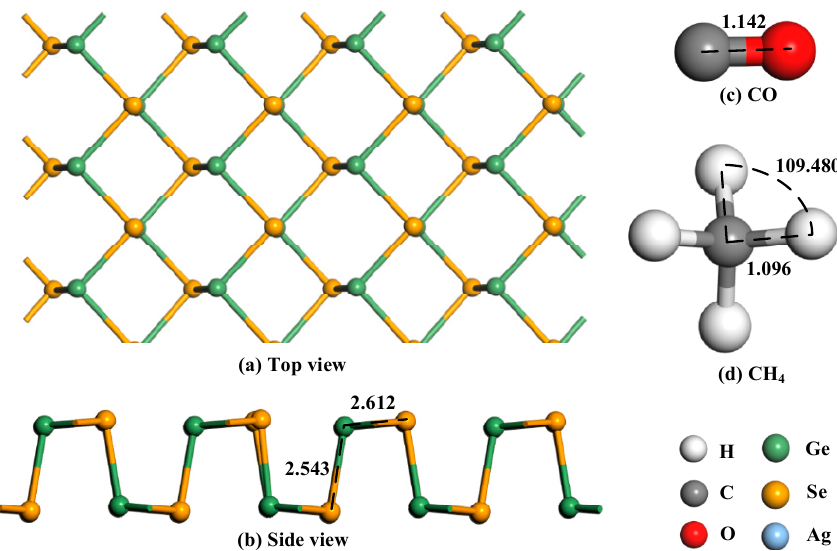
Figure 1. Structures of GeSe and gas molecules ( a ) Top view, ( b ) side view, ( c ) CO molecule, ( d ) CH 4 molecule. The distance is in Å.